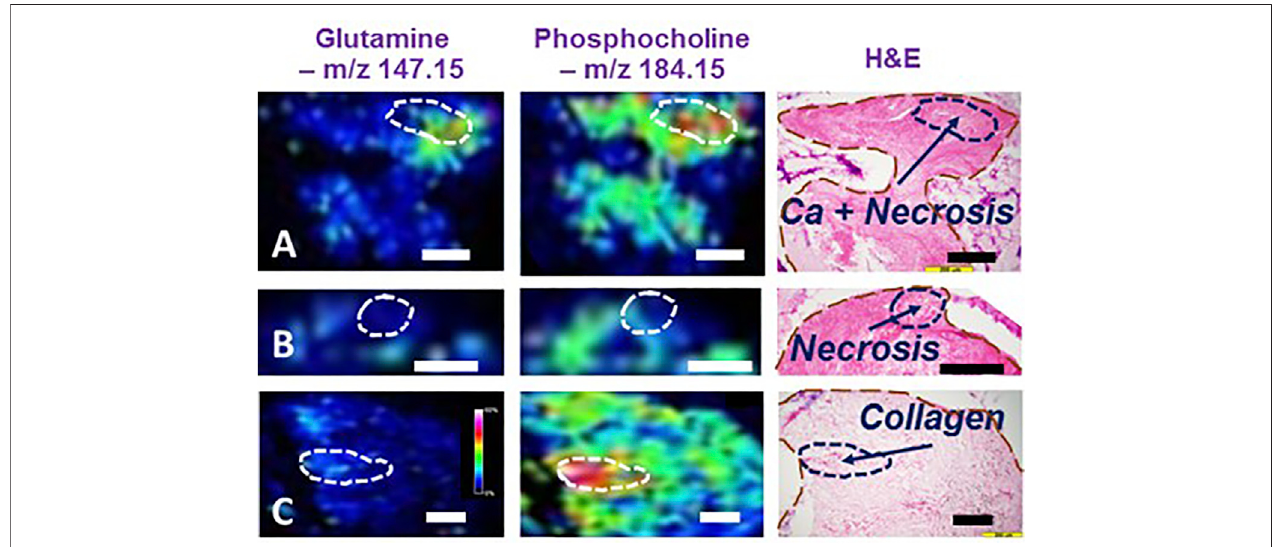
FIGURE 2 | Illustrations of MALDI MSI metabolomic maps of human lung cancer tissues. Interpretation of MALDI MSI results obtained from three human lung cancer cases according to tissue histology. (A) SCC, Stage I, M, 72.2y.o. (B) Adeno, I, F, 71.8, and (C) SCC, I, F, 59.6. In (A) , the MSI region with high glutamine and phosphorylcholineintensitieswascorrelatedwithahistologicalregionfeaturedbycancerlesionsmixedwithnecroses.However,observingnecrosesalone,asshownin (B) , neither of these two metabolites were overexpressed in the MSI. Furthermore, interpretation of the presence of phosphorylcholine requires caution for its increase in collagen was seen in (C) Black and white bars denote 200 μ